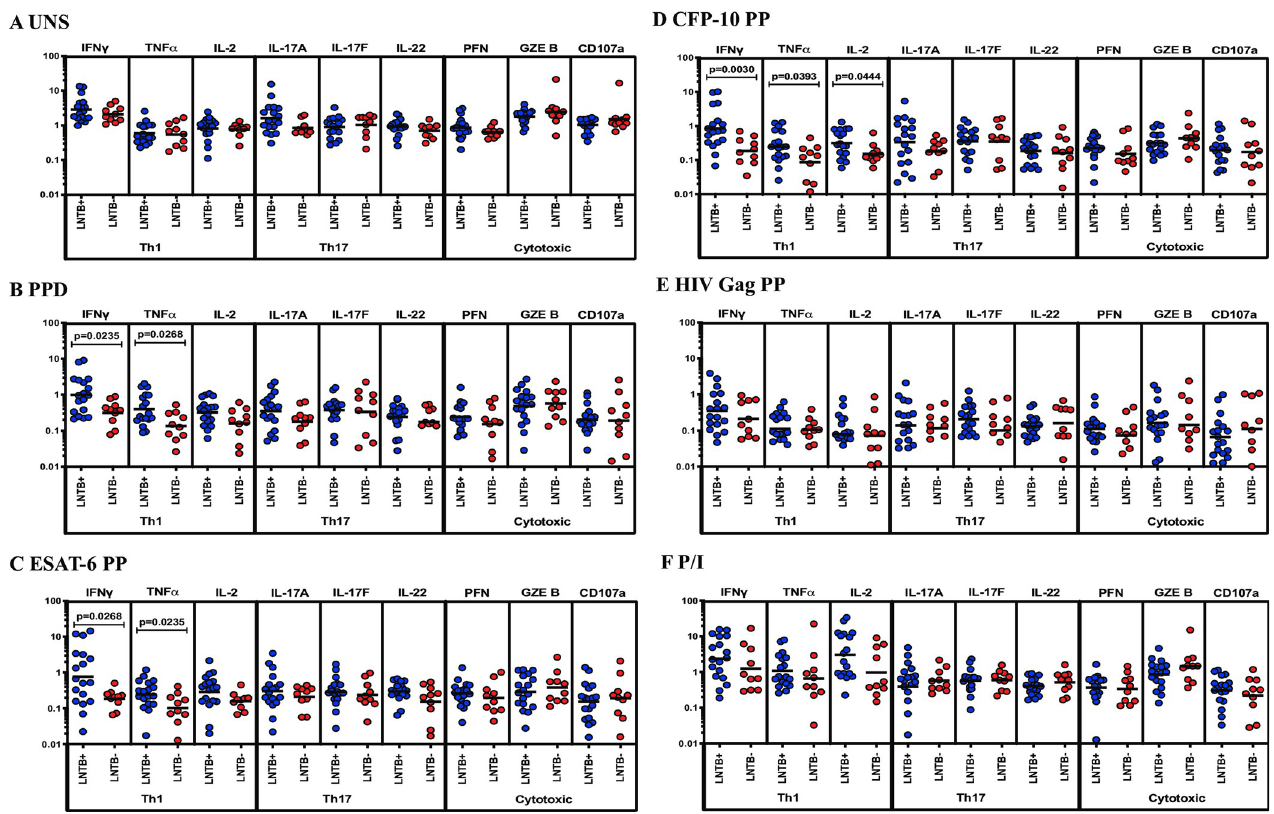
Fig 1. LNTB+ individuals are associated with enhanced antigen-induced frequencies of CD4 + T cells expressing Th1 (IFN γ , TNF α ) cytokines. Lymph node cells from Lymph node (LN) culture-positive tuberculosis (LNTB+, shown in blue colored round circle, n = 18) and LN culture-negative tuberculosis (LNTB-, shown in red-coloured round circle, n = 10) individuals were either unstimulated (UNS) or stimulated with mycobacterial (PPD, ESAT-6 PP, CFP-10 PP), HIV Gag PP and positive (P/I) control antigens for 18 hours. LN cells were harvested, stained and examined using multicolour flow cytometry. (A) UNS (B-D) Mtb antigen (E) HIV Gag PP and (F) positive control (P/I) antigen cultured CD4 + T cell expressing frequencies of Th1 (IFN γ , TNF α , IL-2), Th17 (IL- 17A, IL-17F, IL-22) cytokines and cytotoxic (PFN, GZE B, CD107a) markers were illustrated. The geometric mean was shown using a bar and the Mann- Whitney U test was implemented to calculate the p values and the statistically significant value is represented as p < 0.05. For each individual, we have given the values as net frequencies and they were obtained by deducting the unstimulated frequencies from the antigen-stimulated frequencies.